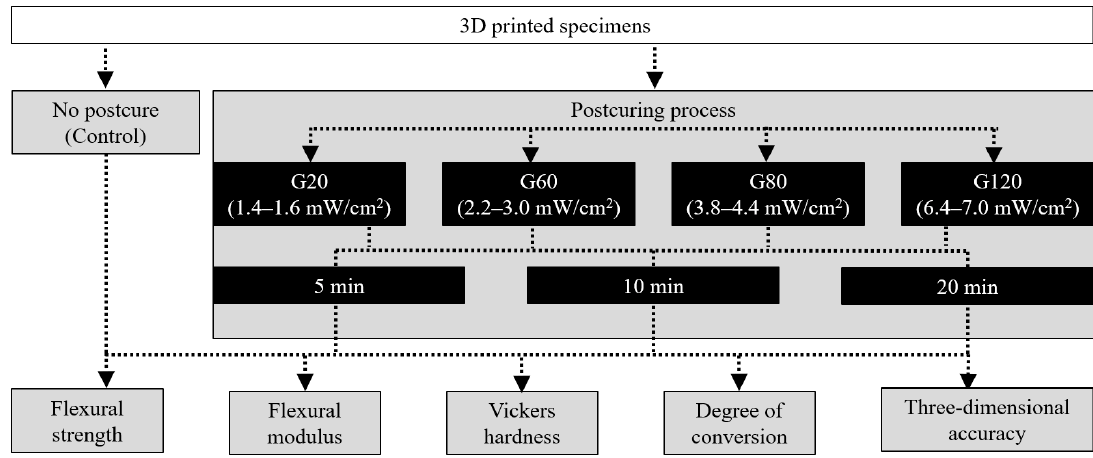
Figure 1. Workflow of the overall experimental process, showing the post ‐ curing conditions and experiment types. FS, flexural strength; FM, flexural modulus; VHN, Vickers microhardness; DC, degree of conversion; 3D, three ‐ dimensional; GS, green state. Table 1. Intensity and temperature of post-curing